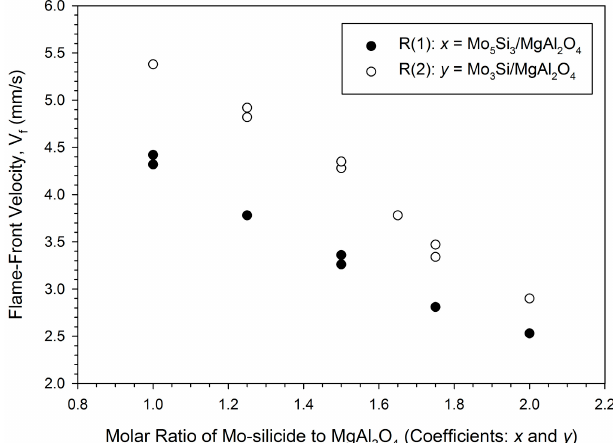
Figure 2. Effect of molar ratio of Mo-silicide to MgAl 2 O 4 on flame-front velocities of Reactions (1) and (2).